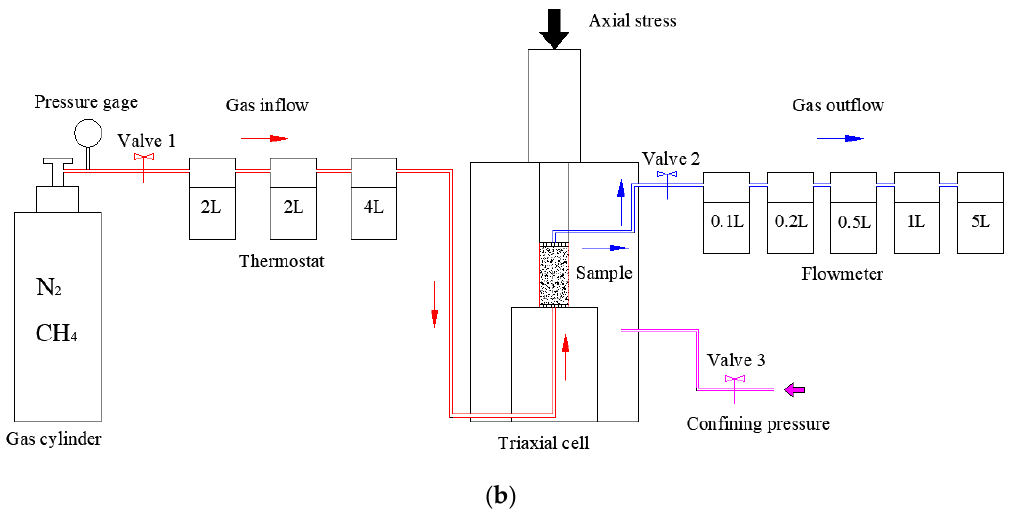
Figure 2. Three-axis creep-seepage test system for coal and rock. ( a ) Image of the triaxial cell; ( b ) schematic diagram of the three-axis creep-seepage test system.